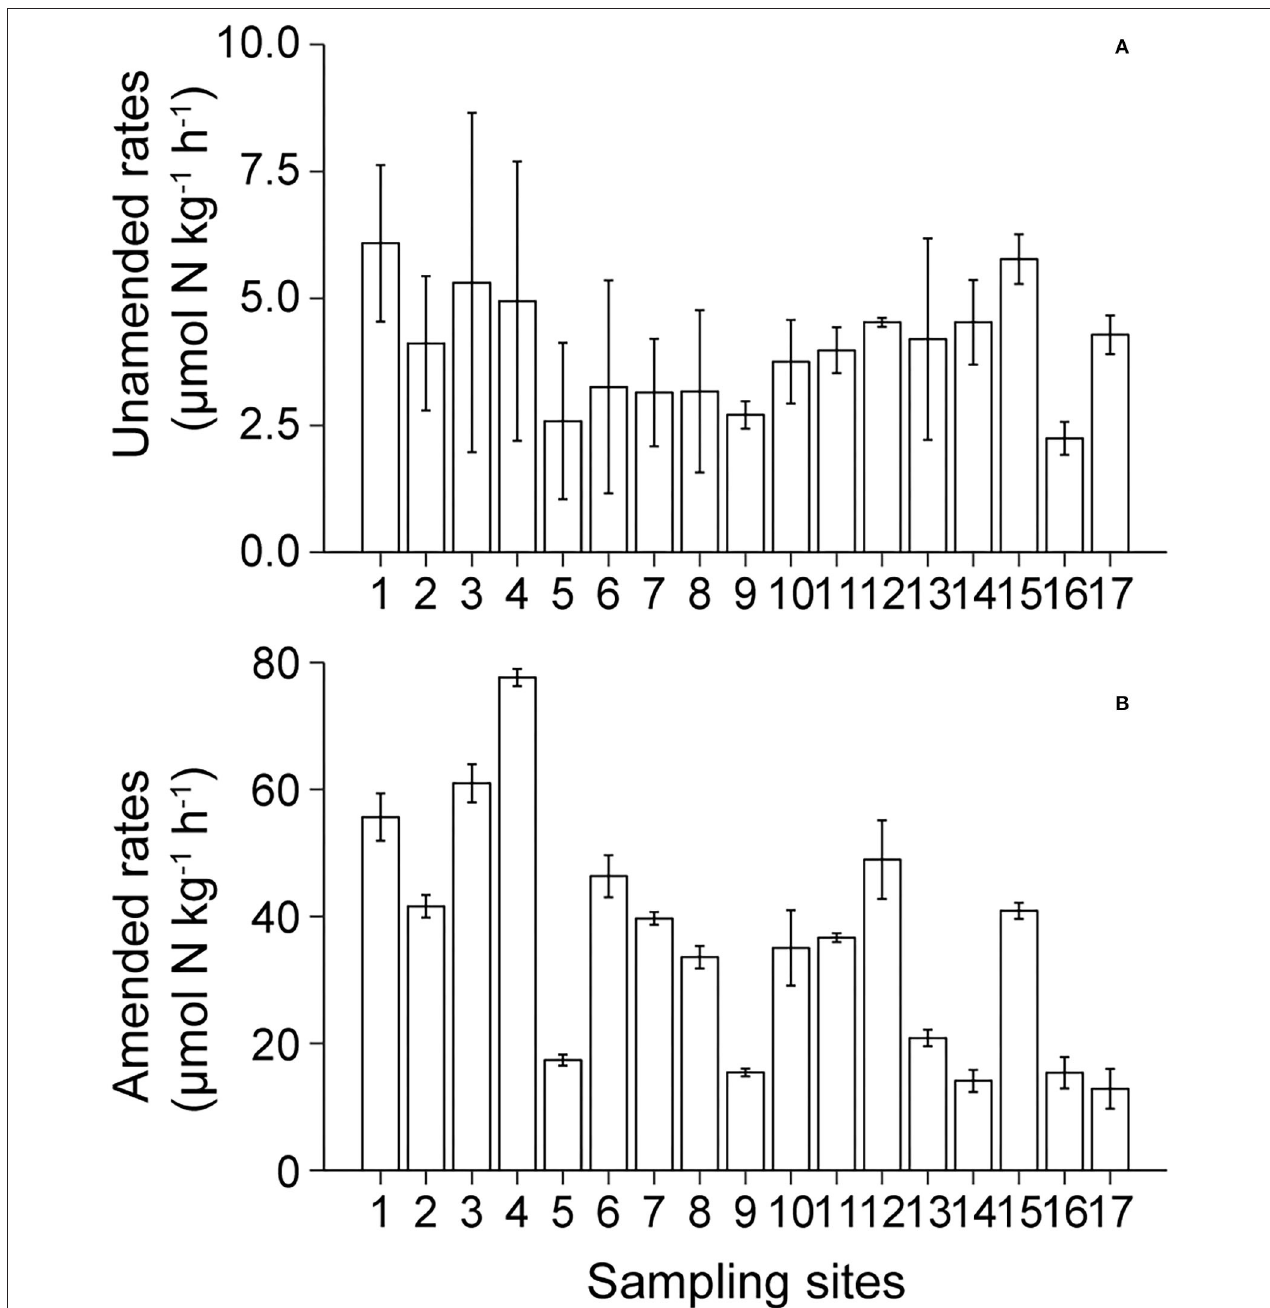
FIGURE 3 | Spatial distribution of the unamended (A) and amended (B) denitrification rates in Lake Bosten.